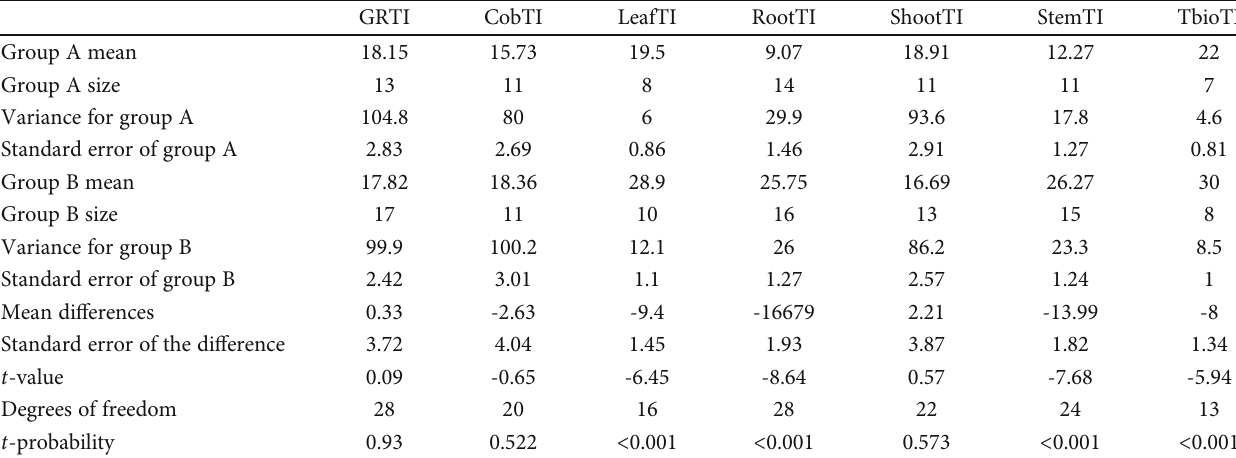
Table 6: A t -test analysis for stress tolerance indices for the derived traits. GRTI CobTI LeafTI RootTI ShootTI